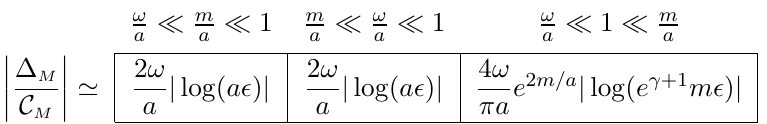
= C in the ! (cid:28) a regime. Note that M M e 2 m=a (cid:28) g 2 = (8 (cid:25) ) is small. a